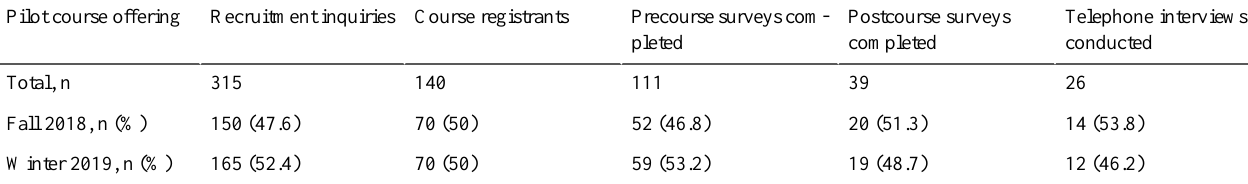
Table 1. Caregiver participants’engagement